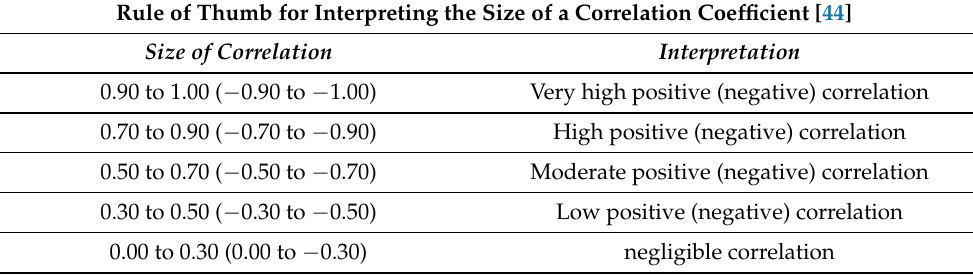
Table 2. Guidelines that help interpret the result size of the Pearson correlation coefficient. Rule of Thumb for Interpreting the Size of a Correlation Coefficient